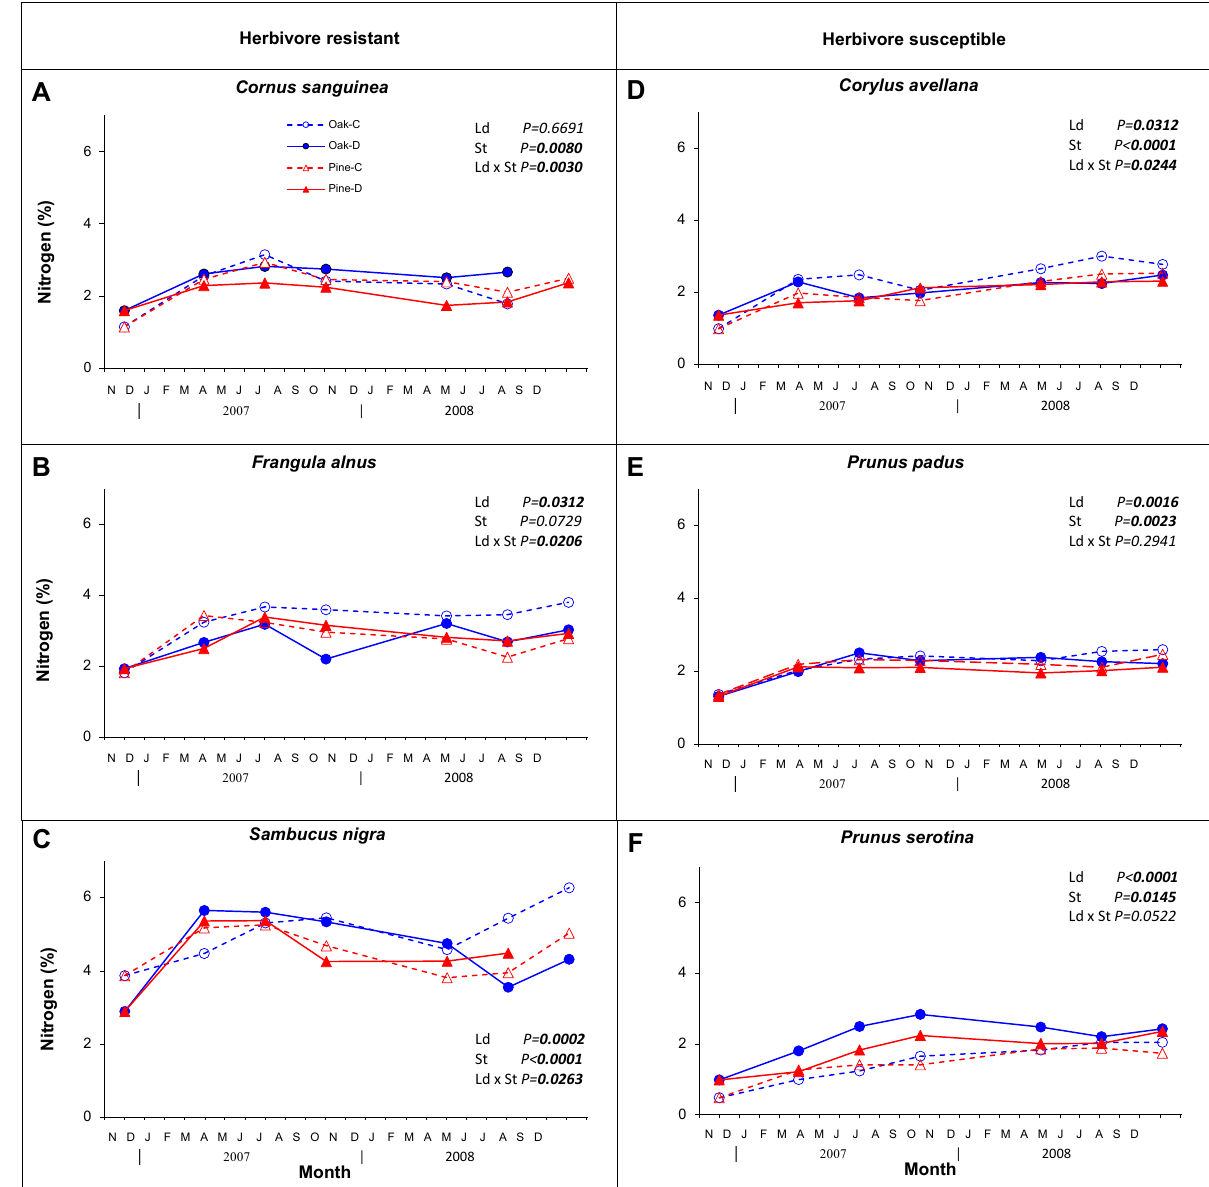
Figure 5. Changes in content of nitrogen (% d.m.) in leaf litter of six understory plant species (herbivore resistant species: Cornus sanguinea —( A ), Frangula alnus —( B ), Sambucus nigra —( C ), on the left and herbivore susceptible species: Corylus avellana —( D ), Prunus padus —( E ), Prunus serotina —( F ), on the right), depending on leaf damage (Ld; control (C) and damaged (D)) in two stand species (St; oak and pine monocultures).